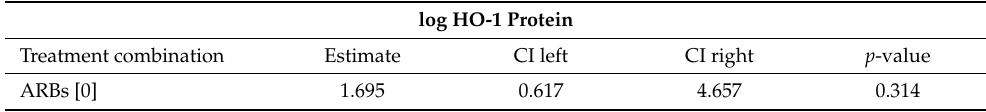
Table 2. Aortic HO-1 protein expression in response to prescription of different combinations of antihypertensive therapies in patients undergoing open surgical repair due to AAA. Data were analyzed by multiple linear regression, and HO-1 was set as the outcome variable. Data were log transformed, and one statistically significant outlier was omitted from the analysis. The estimate shows the proportional increase in HO-1 protein expression if the patient received the indicated therapy, whereas those that did not receive therapy serve as the reference level (=0). Abbreviations: ACE, angiotensin-converting enzyme; ARB, angiotensin II receptor blockers, CCB, calcium channel blockers, CI, confidence